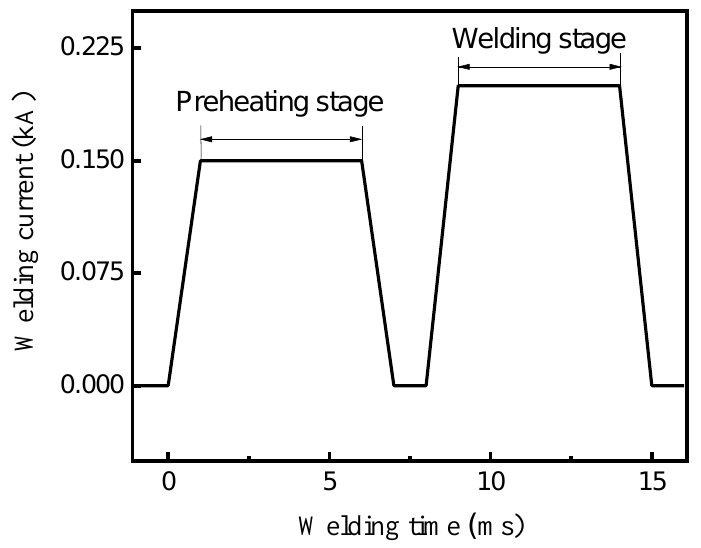
Figure 2. A typical welding current waveform.